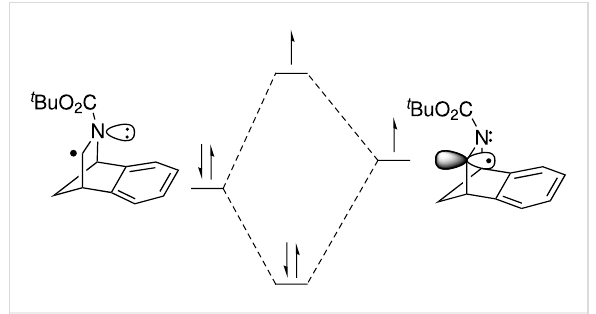
Figure 1: Radical SOMO/α-nitrogen lone-pair interaction in the rearranged radical 7 .